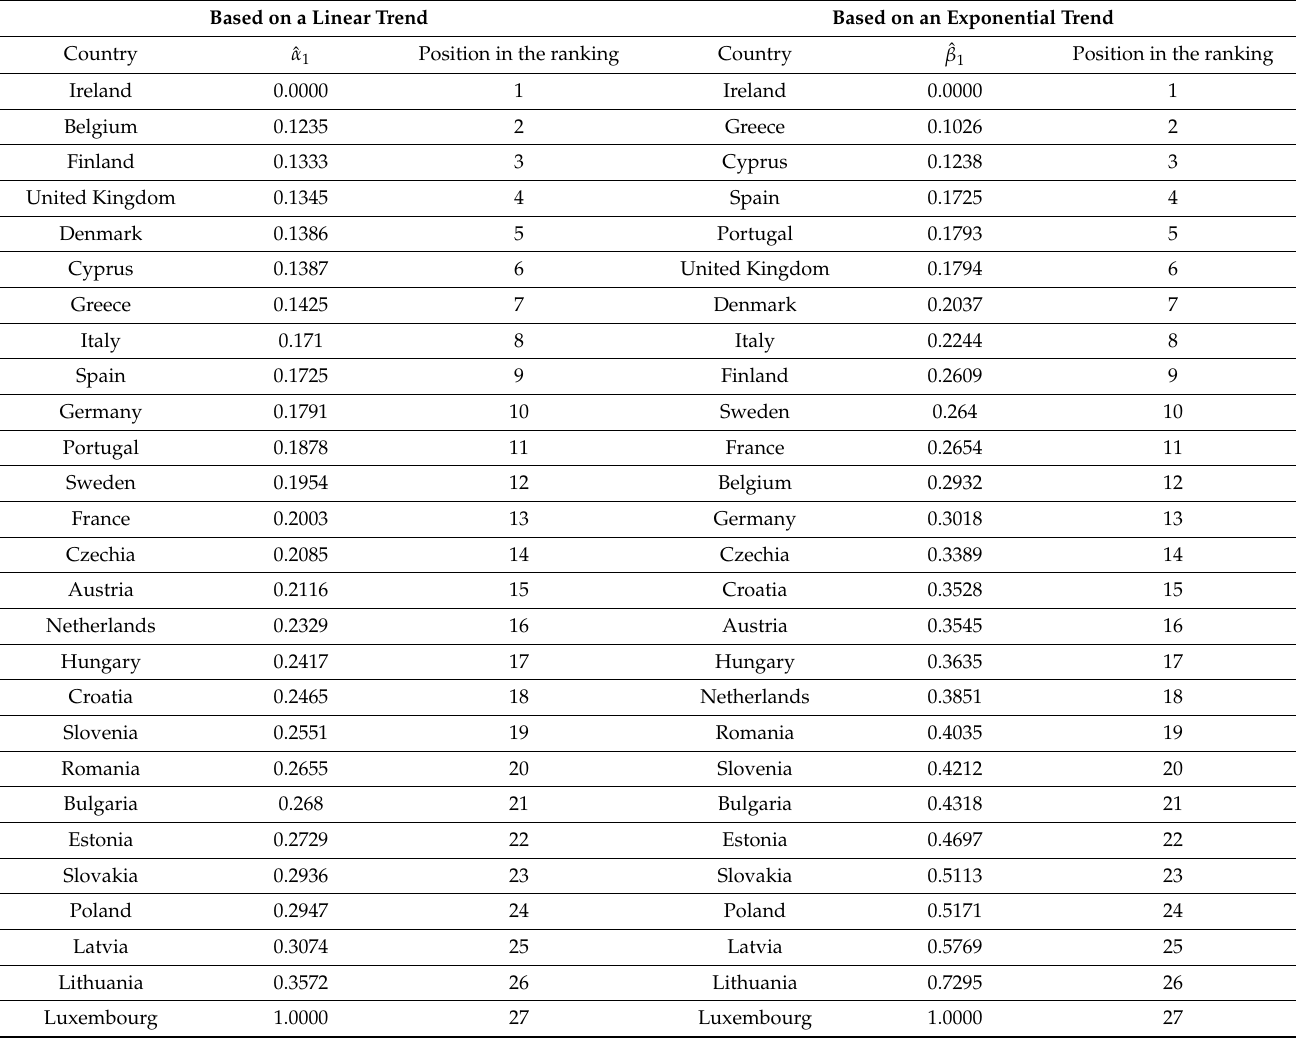
Table 3. Ranking of EU countries based on the parameters of linear and exponential trends. Based on a Linear Trend Based on an Exponential